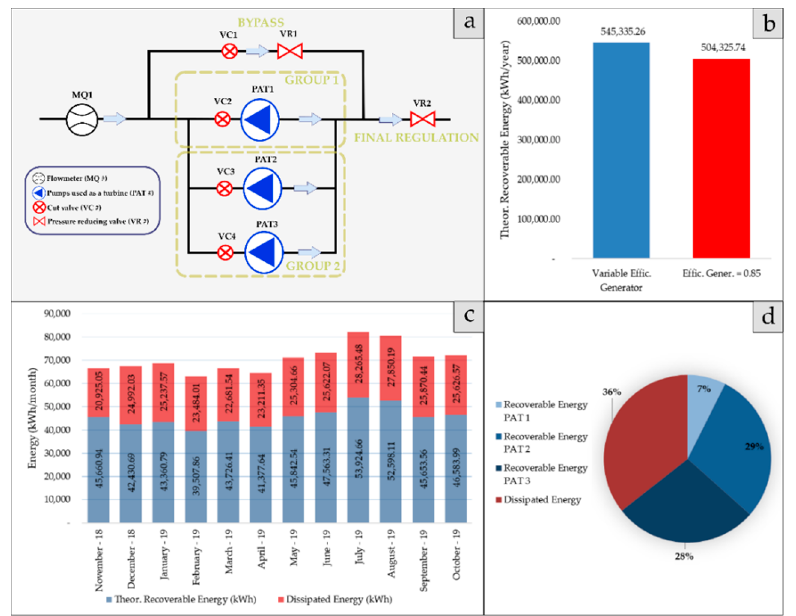
Figure 10. ( a ) PATs installation scheme for point #7. ( b ) Theoretical recovery energy for each scenario. ( c ) Energy recovered by PAT. ( d ) Energy distribution by month.